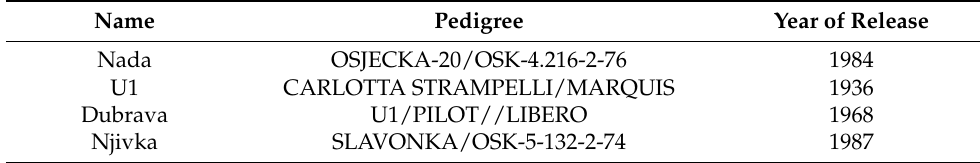
Table 1. Name, pedigree data, and year of release of genotypes used in the present